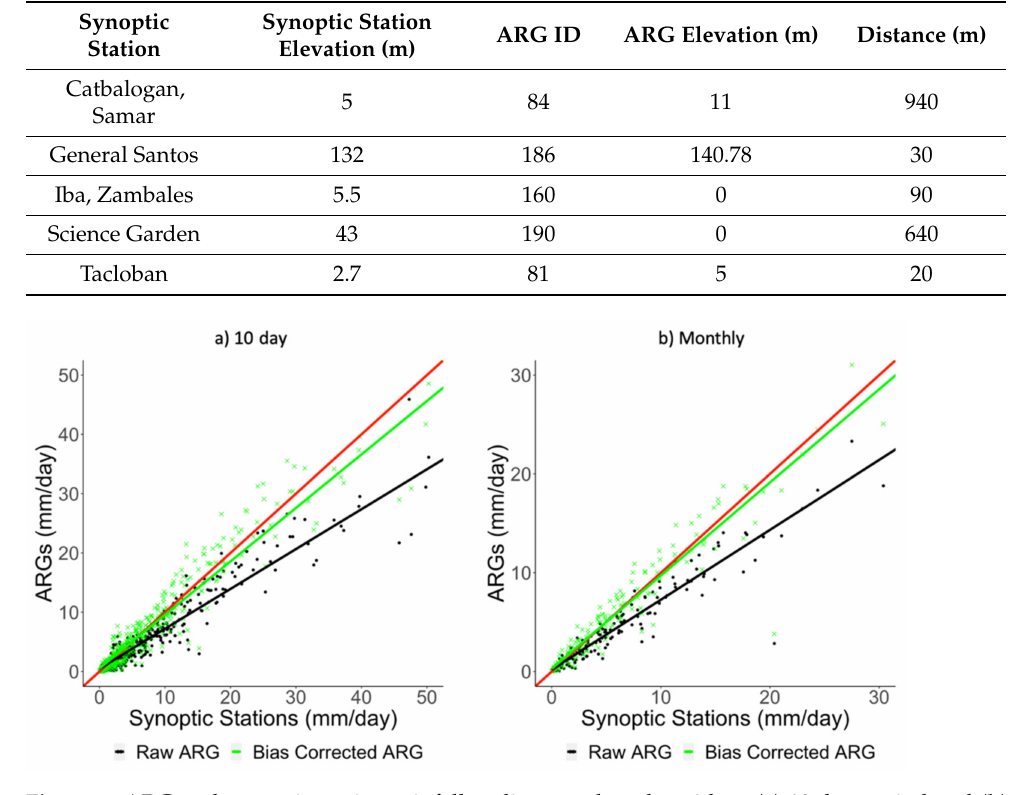
Figure 6. ARG and synoptic station rainfall at distances less than 1 km. ( a ) 10 day period and ( b ) monthly rainfall represented by black points are raw ARG data whereas green points are corrected data. Table 2. Statistics before and after bias correction of ARG rainfall